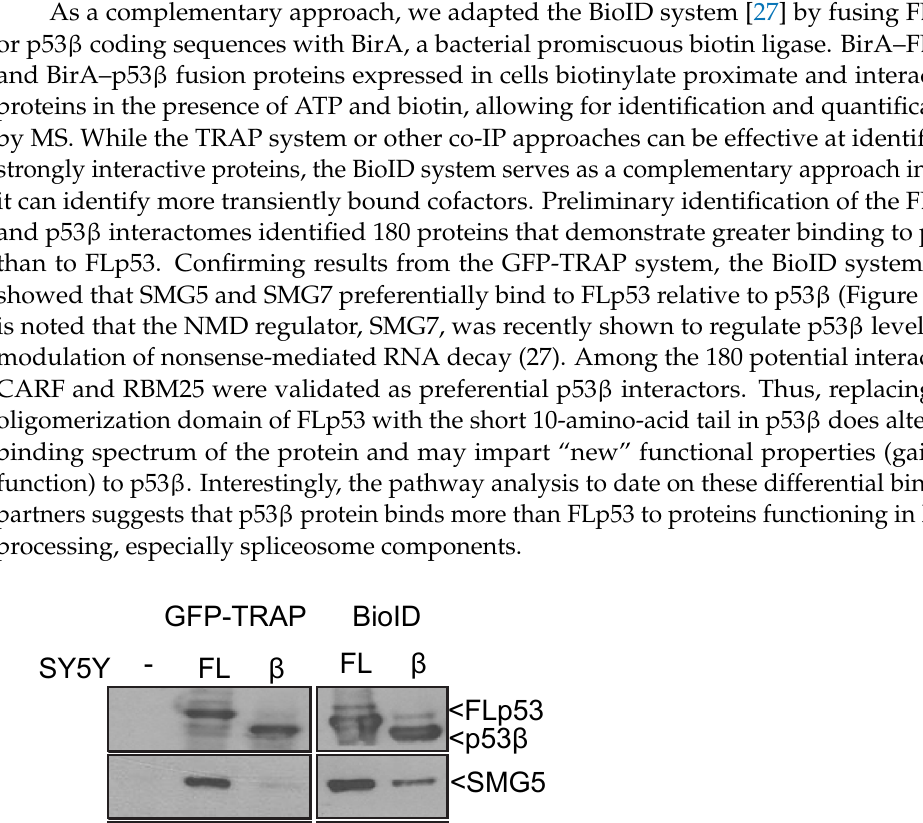
Figure 4. Probing the p53 β interactome by the GFP-TRAP system and p53 BioID. Left: Validation of hits from the GFP-TRAP system performed in SY5Y-inducible cell lines (left panels) and from p53 BioID system in MCF7 cells (right panels). Right: Bar graph shows a summary of the number of proteins identified in the GFP-TRAP and BioID systems. Blue: the number of proteins that bind ≥ 2 fold more to p53 β than to FLp53; green: the number of proteins that bind ≥ 2 fold less to p53 β than to FLp53; and grey: the number of proteins in between. As a complementary approach, we adapted the BioID system [27] by fusing FLp53 or p53 β coding sequences with BirA, a bacterial promiscuous biotin ligase. BirA–FLp53 and BirA–p53 β fusion proteins expressed in cells biotinylate proximate and interacting proteins in the presence of ATP and biotin, allowing for identification and quantification by MS. While the TRAP system or other co-IP approaches can be effective at identifying strongly interactive proteins, the BioID system serves as a complementary approach in that it can identify more transiently bound cofactors. Preliminary identification of the FLp53 and p53 β interactomes identified 180 proteins that demonstrate greater binding to p53 β than to FLp53. Confirming results from the GFP-TRAP system, the BioID system also showed that SMG5 and SMG7 preferentially bind to FLp53 relative to p53 β (Figure 4). It is noted that the NMD regulator, SMG7, was recently shown to regulate p53 β levels via modulation of nonsense-mediated RNA decay (27). Among the 180 potential interac- tors, CARF and RBM25 were validated as preferential p53 β interactors. Thus, replacing